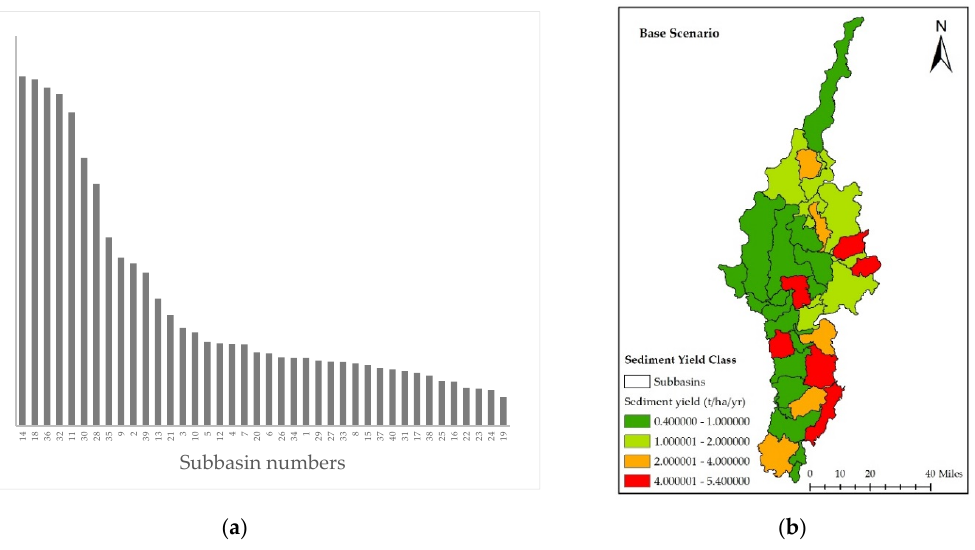
Figure 5. ( a ) Model simulated sediment yield from sub-basins in descending order; ( b ) subbasins classified according to average annual sediment yield per unit area.